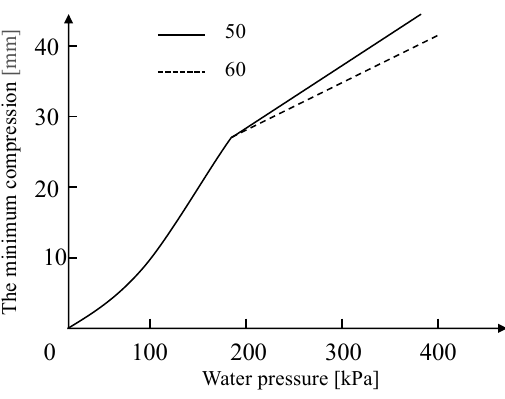
Figure 6. The relationship curve between the minimum compression and water pressure (redrawn according to the results of Tang, Guan and Wan [24]).